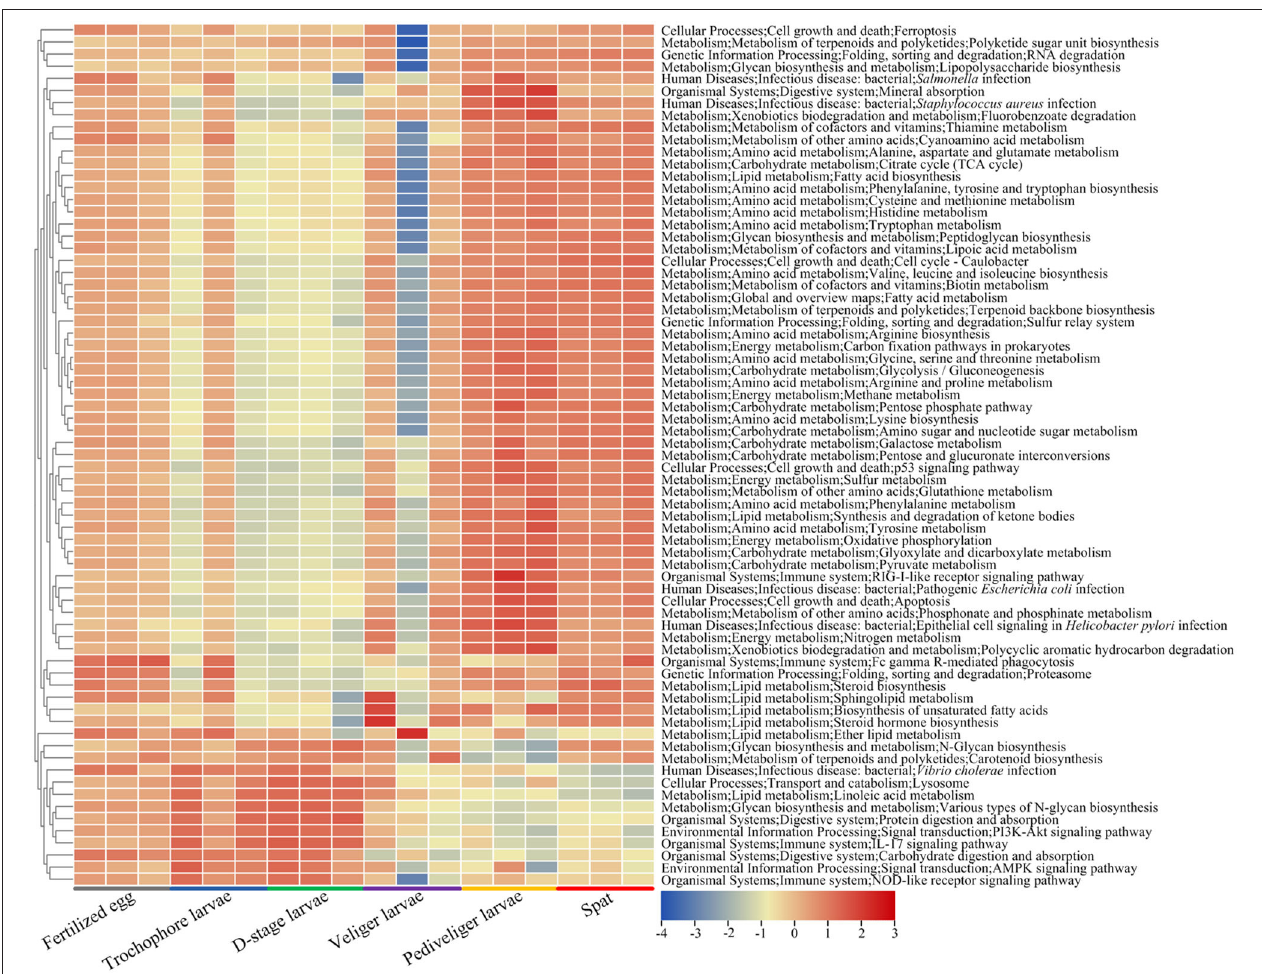
FIGURE 6 | Heatmap shows the predicted functional potentials of larval bacterial community during host development. The abundances of predicted functional potentials are log 10